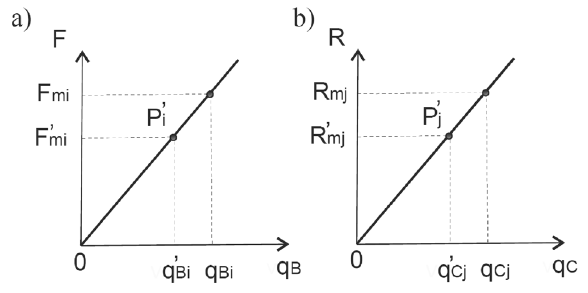
Fig. 3. Determining of the load: a) for bolts, b) for the contact layer